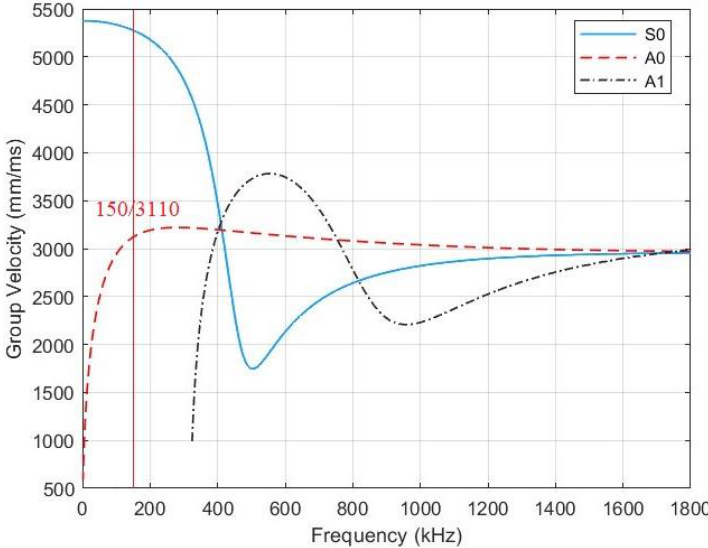
Figure 12. Dispersion curve on a carbon plate with the thickness of 5 mm.